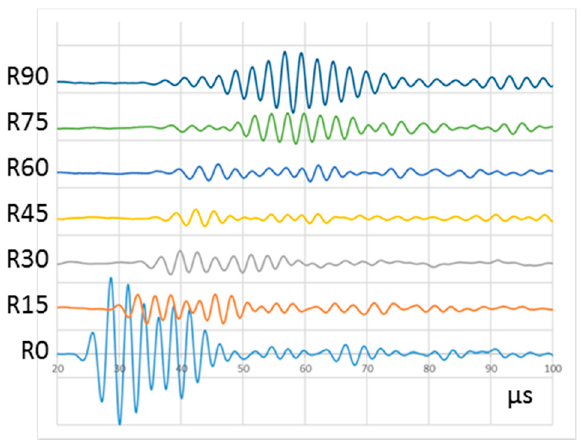
Figure 14. Signals acquired in R0 to R90 following procedure P1. An offset was added to each signal for easy display. Vertical scale is 100 mV/div. Table 3. Peak-to-peak voltage measured (in mV) at R0 to R90 in the UGWT run following procedure P1 and procedure P2 with 10 PWAS and di ff erent delays in